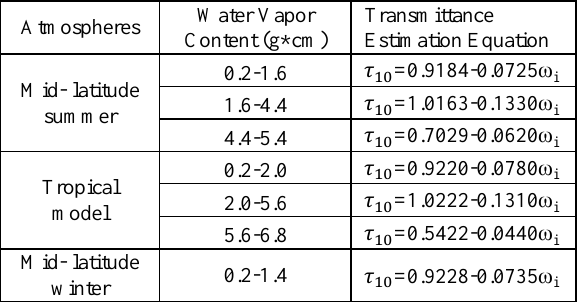
Table 5. Derivation of atmospheric transmittance for